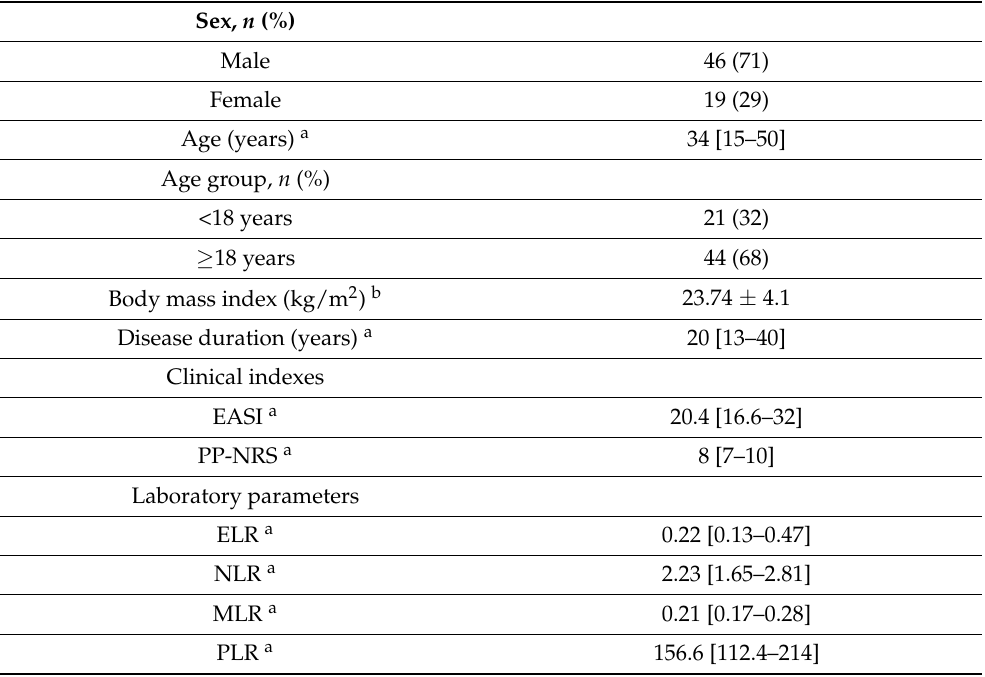
Table 1. Demographics and baseline characteristics of patients with atopic